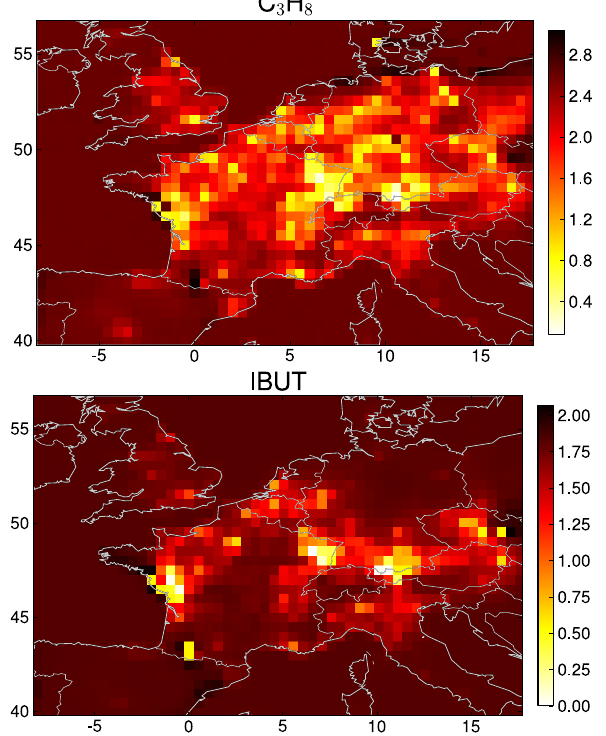
Fig. 7. Plot of the gridded unitless standard deviations of the scaling variables α that represent a posteriori uncertainties of the gridded emission fluxes of propane (C 3 H 8 , left) and isobutane (IBUT, right), in case